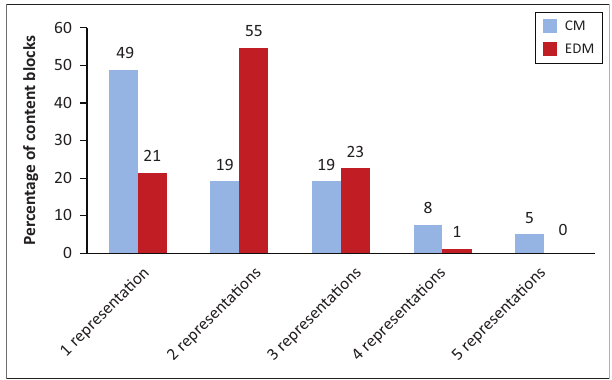
FIGURE 9: Percentage of content blocks that utilise one or more function representations (flow diagram, table, equation, graph, written